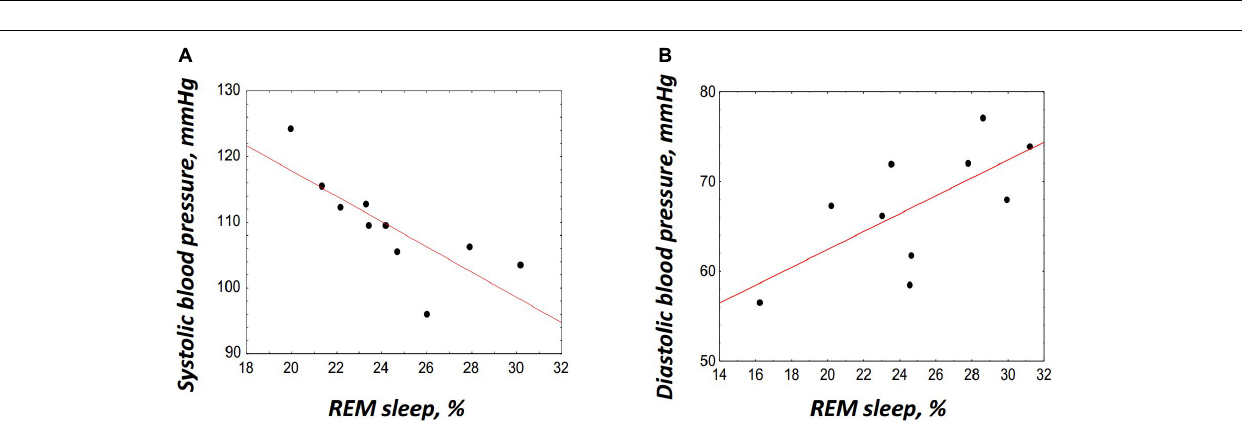
FIGURE 5 | Correlations between the rapid eye movement (REM) sleep and blood pressure. (A) Correlation with the systolic blood pressure on DI19, r = –0.78, p = 0.008. (B) Correlation with the diastolic blood pressure on R + 1, r = 0.68, p = 0.031. The correlation coefficients were obtained using Pearson’s correlation